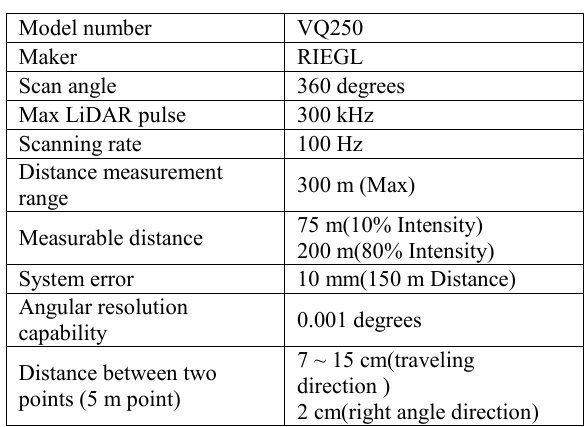
Figure 3. Example of LiDAR data by MX-8